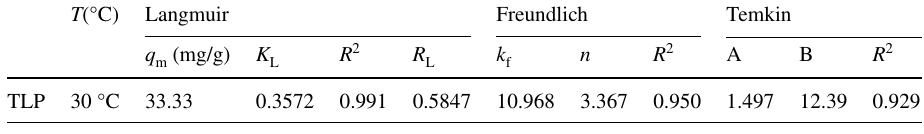
Table 4 Thermodynamic parameters for the adsorption of CR on activated TLP